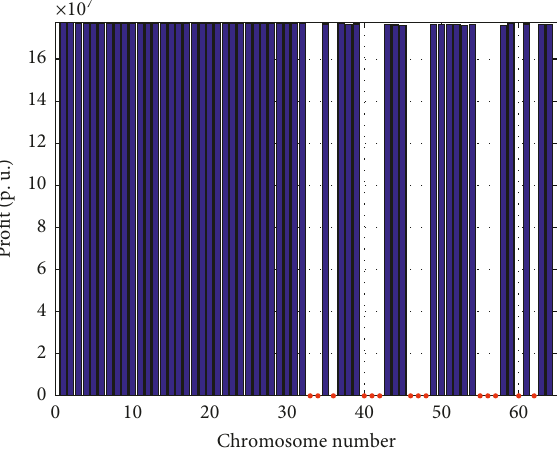
Figure 12: Profit of community at each chromosome at iteration 1.